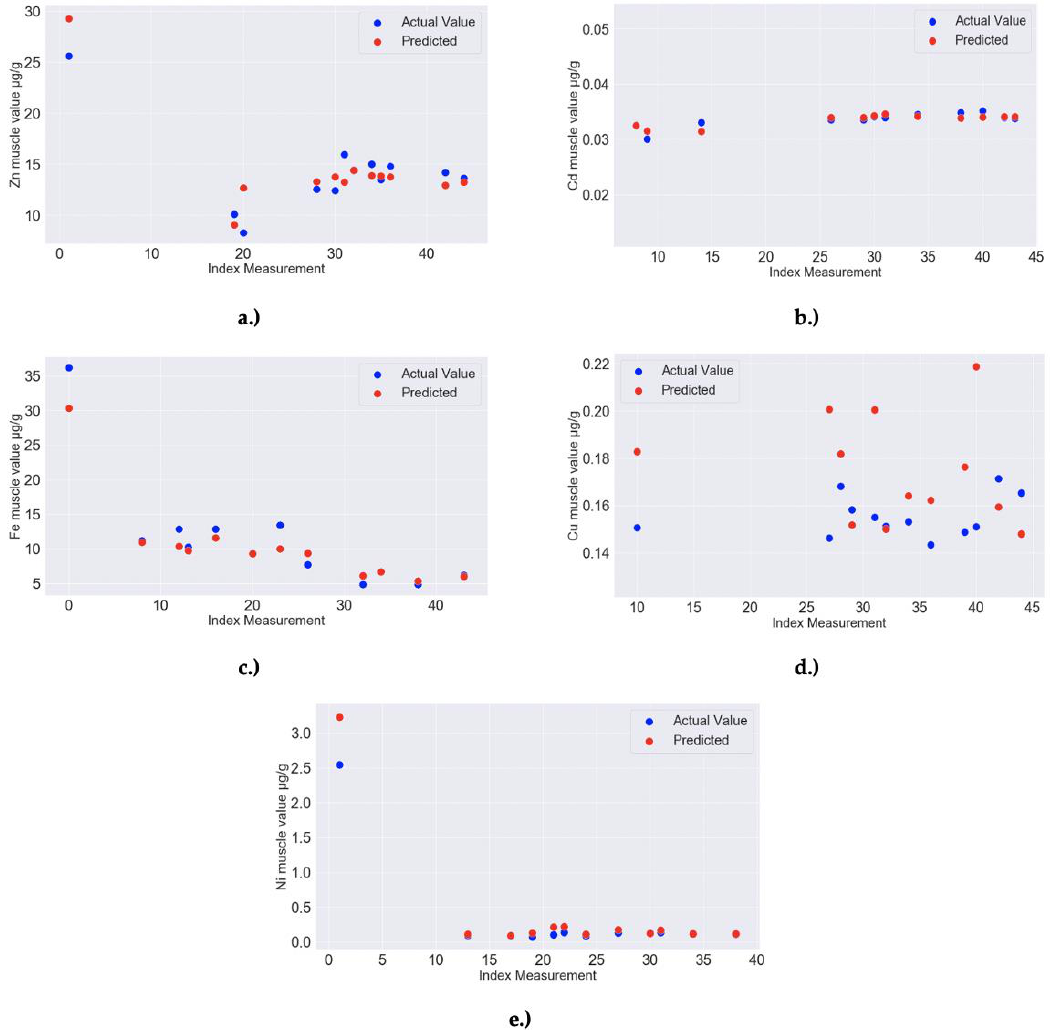
Figure A5. Prediction of heavy metals concentration for turbot muscle tissues—actual values vs. predicted value for second dataset group—Section 2.2.3. (( a ). prediction for Zn concentration; ( b ). prediction for Cd concentration; ( c ). prediction for Fe concentration; ( d ). prediction for Cu concentration; ( e ). prediction for Ni concentration).